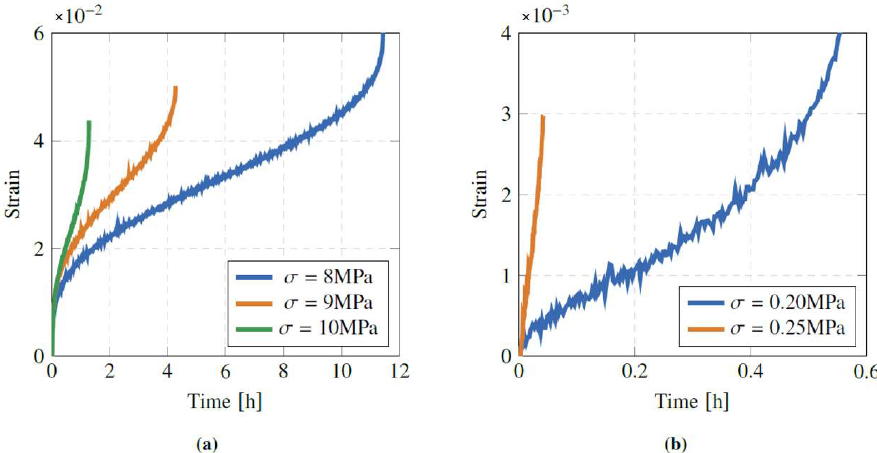
Figure 3. Creep tests at 1300 ◦ C. ( a ) Compression. ( b )